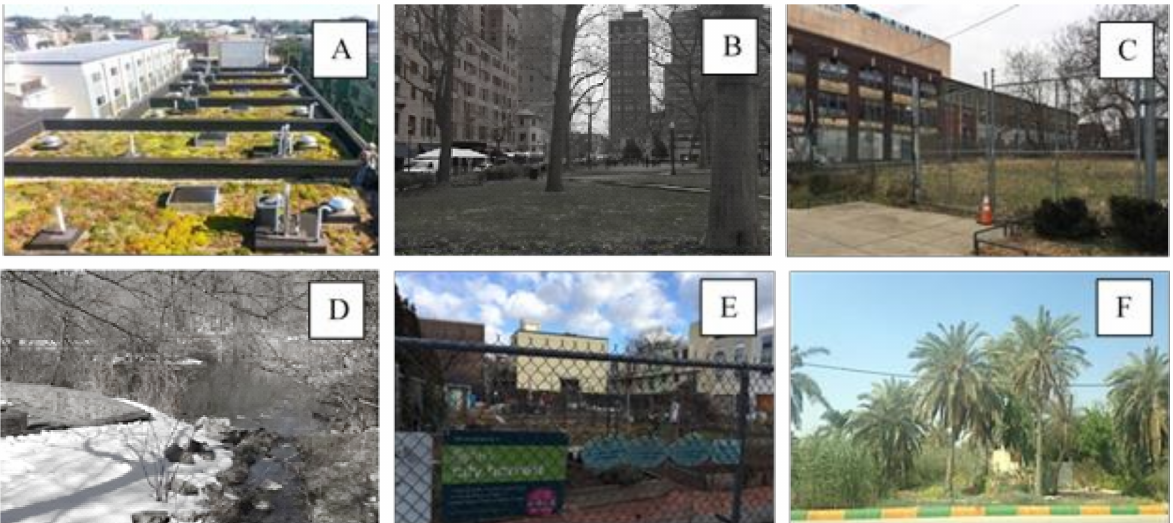
Figure 2. Diverse small-scale urban green infrastructure. ( A ) A small green roof on top of a residential building, USA. ( B ) A local public park, USA. ( C ) A privately owned piece of vacant land, USA. ( D ) Rain garden development, USA. ( E ) A community garden, USA. ( F ) Street trees, Iran. Photos taken by the